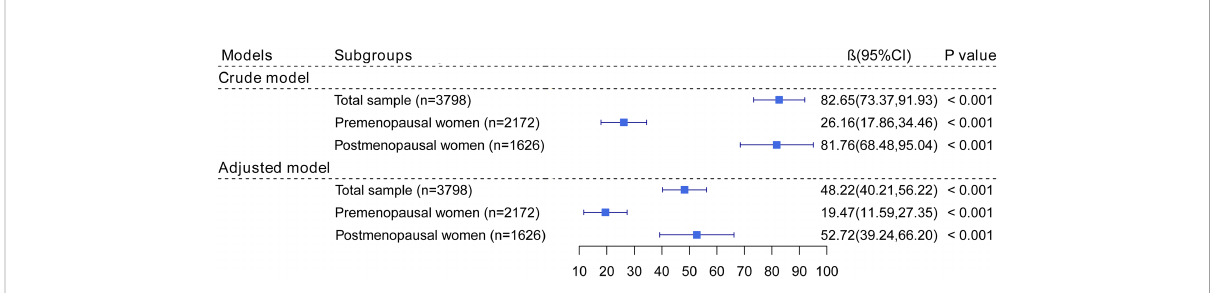
FIGURE 2 The association of blood lead levels with FSH. In adjusted models, age, BMI, race, current smoking, current alcohol consumption, education levels, marital status, annual household income, history of hypertension and diabetes, ever been pregnant, use of hormone therapy, and had at least one ovary removed were adjusted. In postmenopausal women, years since menopause was additionally adjusted.